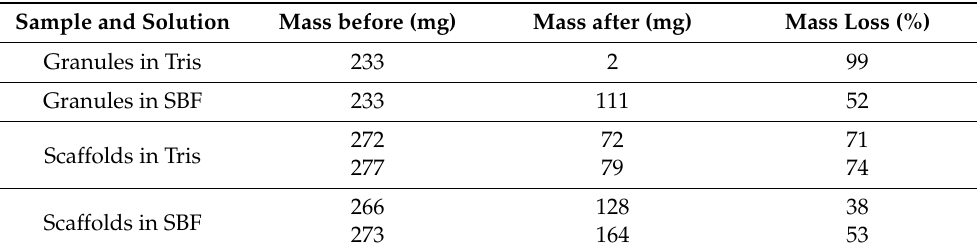
Table 1. Masses of the granules (one specimen) and amorphous scaffolds (two specimens) before and after the 1-week dissolution tests.